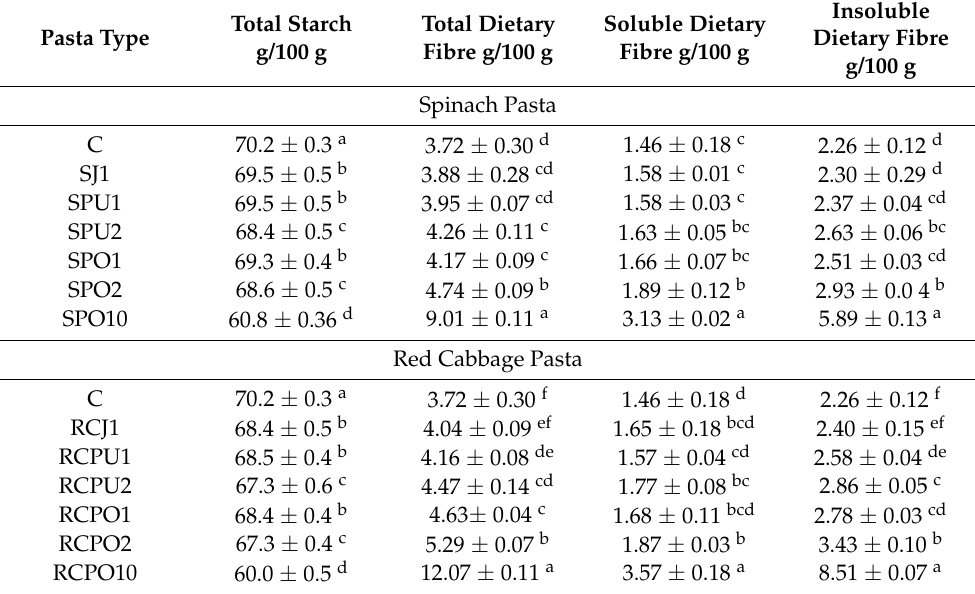
Table 2. Dietary Fibre and Starch content of cooked pasta. Pasta Type